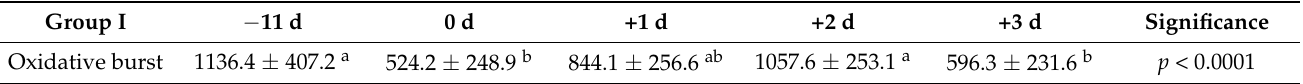
Table 4. Values representing the average and the standard deviation of the oxidative burst performed with blood samples collected from animals in group I (1 to 15) at the moments − 11 d, 0 d, +1 d, +2 d, and +3 d. Statistical difference measured according to the Tukey–Kramer test—Beltsville, 2003. Group I − 11 d 0 d +1 d +2 d +3 d Significance Oxidative burst 1136.4 ± 407.2 a p < 0.0001 Distinct letters on the same line indicate a significant statistics difference between the results, 0 d = immediately after the